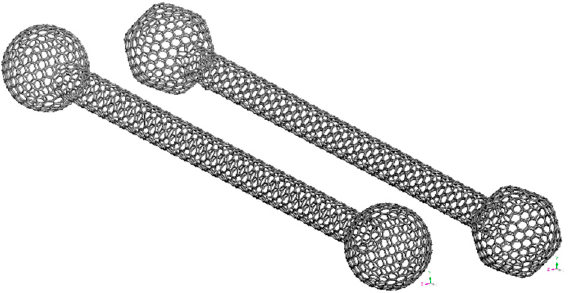
Figure 4. The BS SWCNT molecular structure before and after the GO with respect to the global Cartesian coordinate system ( x , y , z ).